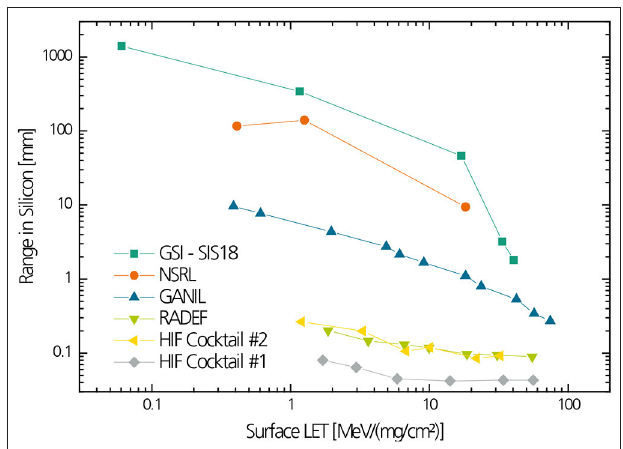
FIGURE 10 | Range in silicon vs. effective LET for several European heavy ion accelerators. Also included is the NASA Space Radiation Laboratory (NSRL) at the Brookhaven National